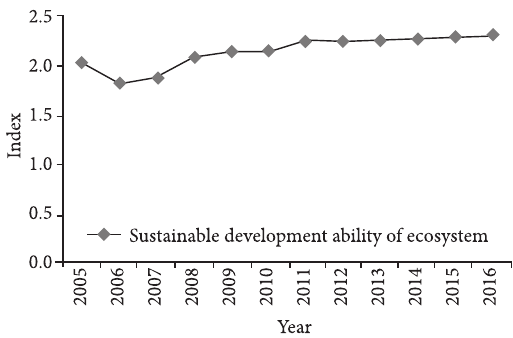
Figure 7. Variation trend of sustainable development capability of